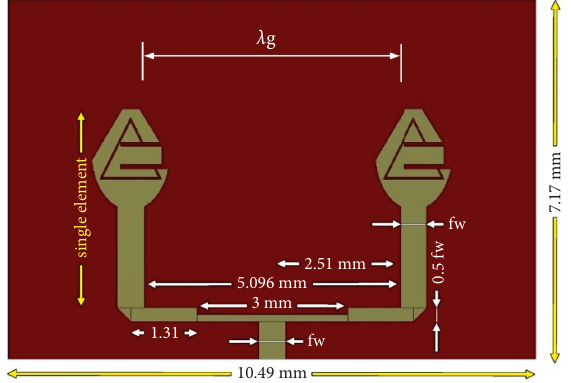
Figure 8: : 1 × 2 Array with the